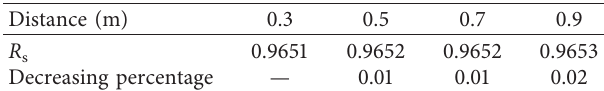
Table 4: Effect of distance of drilling borehole on the end resistance of the existing foundation pile.